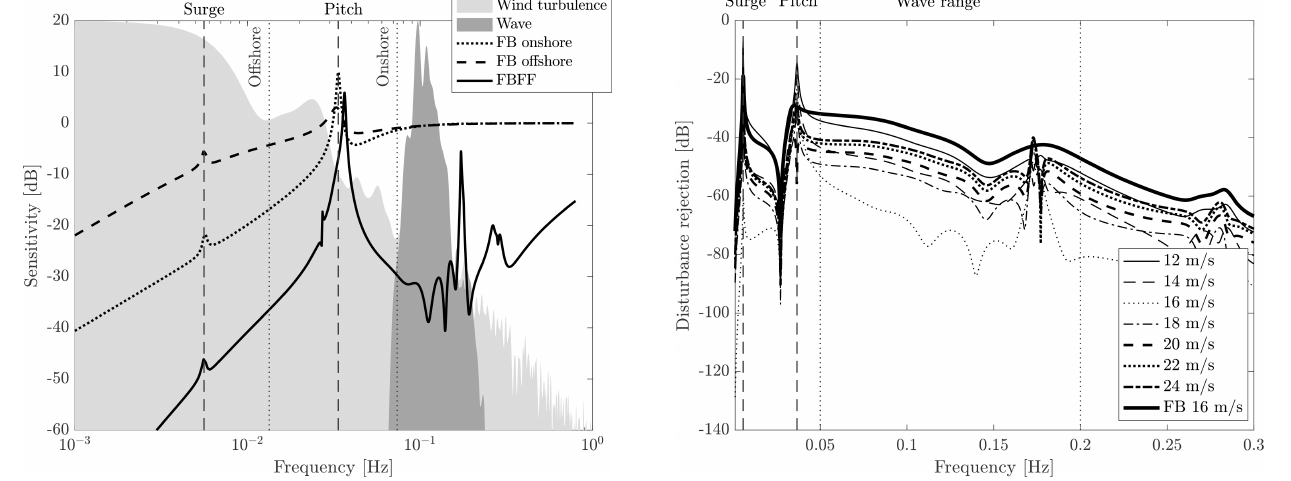
Figure 6. Disturbance rejection function of the feedback– feedforward controller in above-rated winds. The feedback con- troller (FB) in 16m/s wind is reported for comparison. The verti- cal dashed lines are the frequency of the platform surge and pitch modes, whereas the frequency range where waves are active is en- closed by the vertical dotted